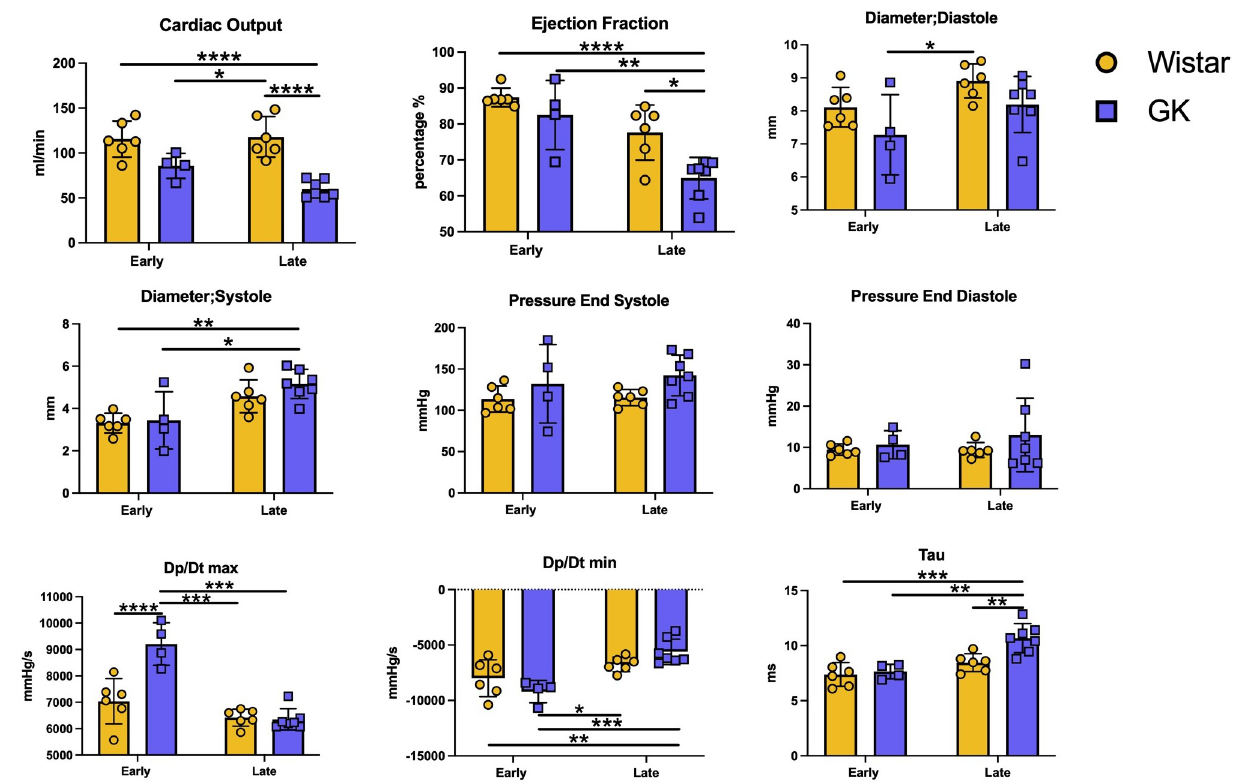
Fig 1. Echocardiograph and cardiac catheterization parameters of Wistar and GK rats over time. A-D represents echocardiographic analysis taken from short axis M-mode view demonstrating (A) cardiac output, (B) ejection fraction, (C) diameter in systole and (D) diameter in diastole. E-I represent analysis of cardiac catherization (E) systolic pressure, (F) end diastolic pressure, (G) Dp/dt max, (H) Dp/dt min, and (I) Tau. Where early = 28 weeks, Late = 48 weeks GK = Goto Kakizaki rats, Wistar = Wistar rats. � = p < 0.05, �� = p < 0.01, ��� = p < 0.001 and ���� = p < 0.0001 when comparing groups. A Two-Way ANOVA with multiple comparisons Holm-Sidak test was used to compare groups across different time points. Yellow = Wistar and Blue = GK. Data is expressed as mean ± SEM N = 4–8 per group.